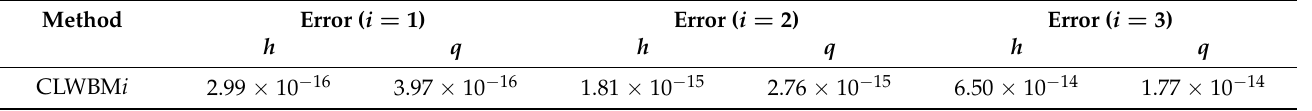
Table 15. Test 4.2. Differences in L 1 -norm with respect to the stationary solution for CLWBM i ( i = 1,2,3) for the 100-cell mesh at time t = 9